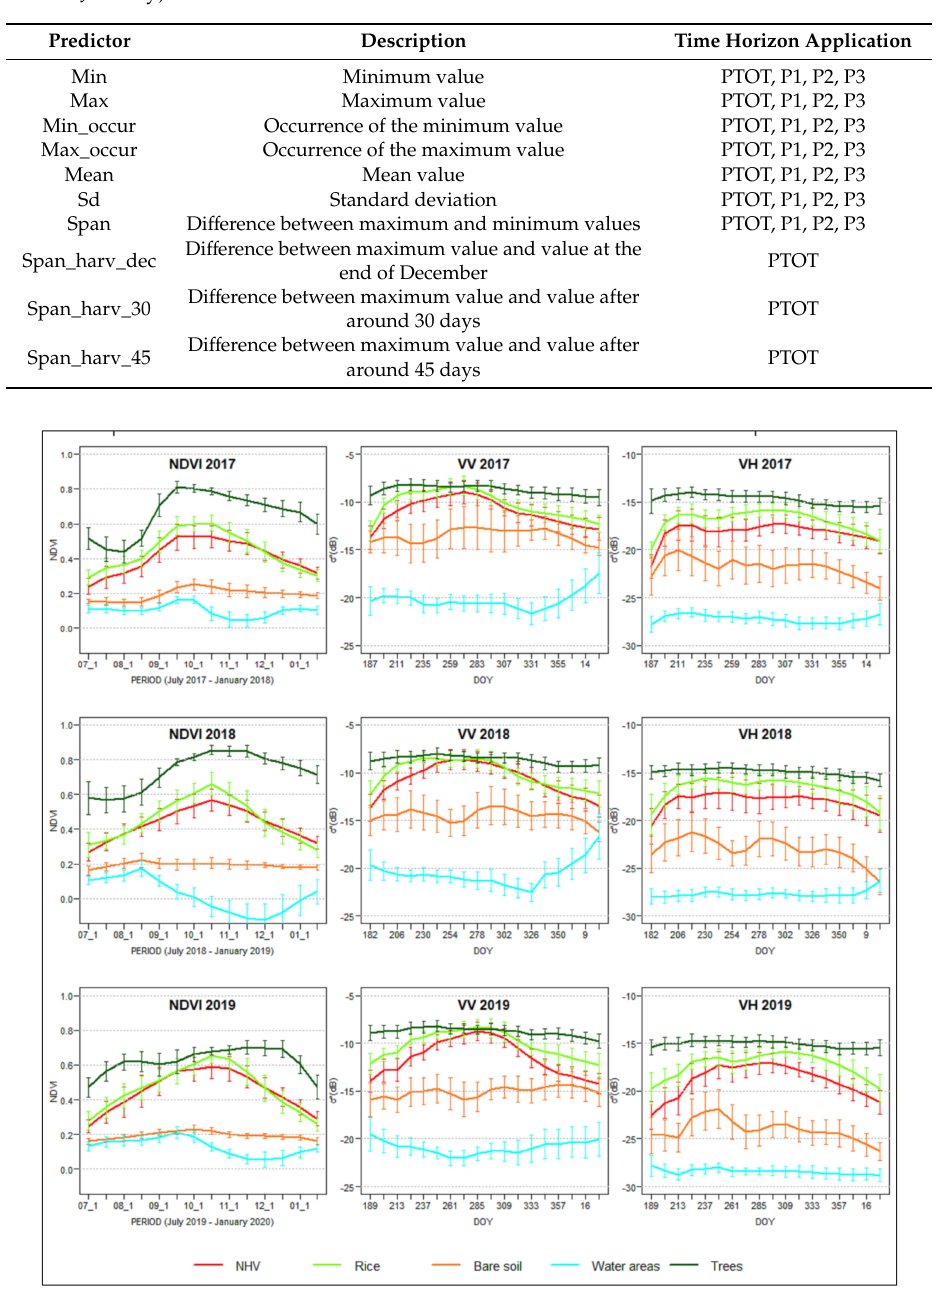
Figure 8. Average temporal patterns of NDVI, VV, and VH backscatters for land cover classes mapped in the three seasons investigated. Error bars indicate standard